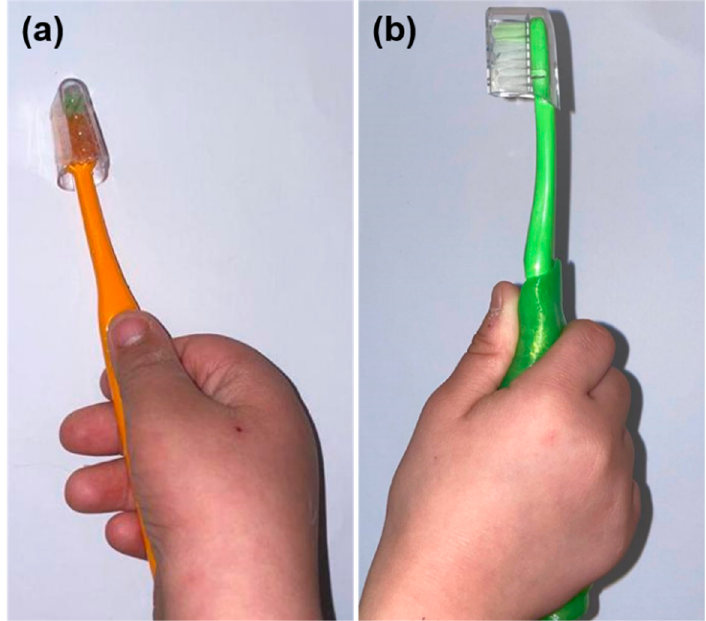
Figure 4. ( a ) Conventional handle toothbrush and ( b ) customized handle toothbrush in children with Down syndrome. Down